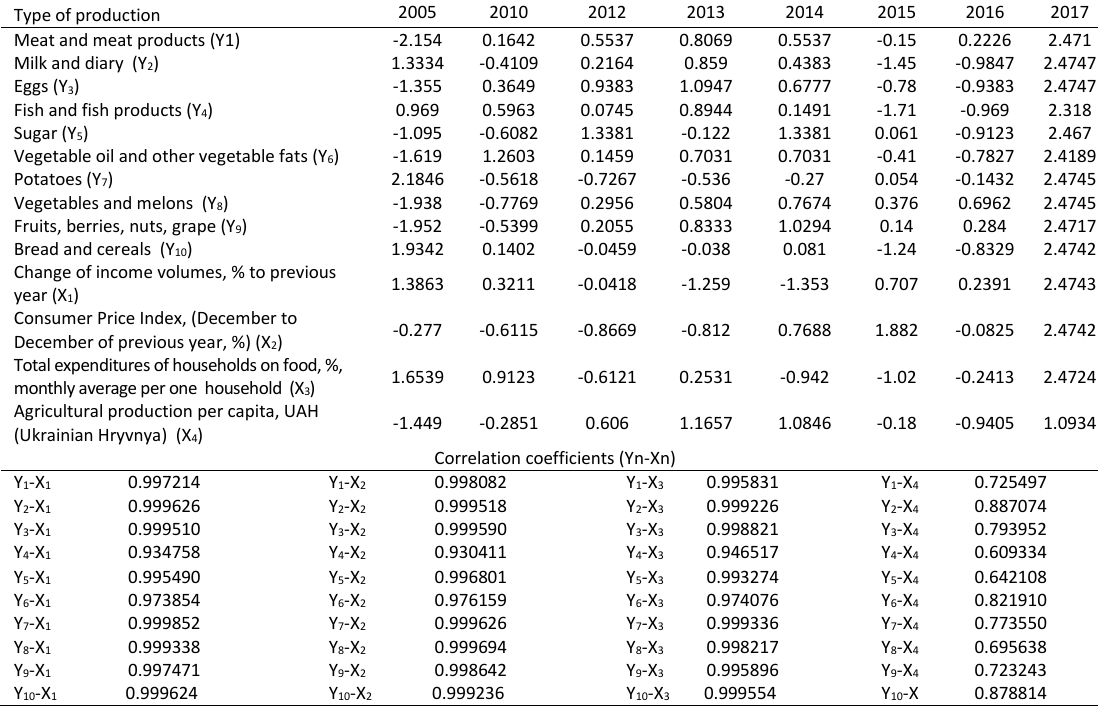
Table 1: Research of connection between the level of consumption of vegetable and animal products and socio-economic factors in Ukraine in 2010-2017 (correlation analysis) (State Statistics Service of Ukraine, 2018a; State Statistics Service of Ukraine, 2018b; State Statistics Service of Ukraine, 2018f) Type of production